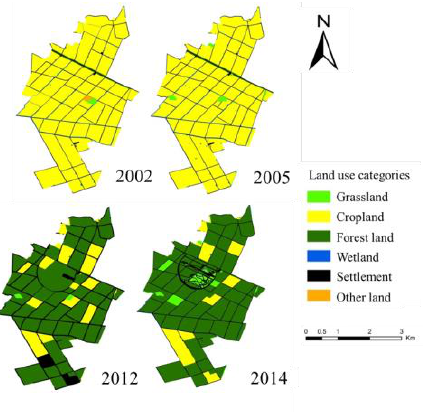
Figure 2. Land use changing during 2002-2014 in Linhousilin